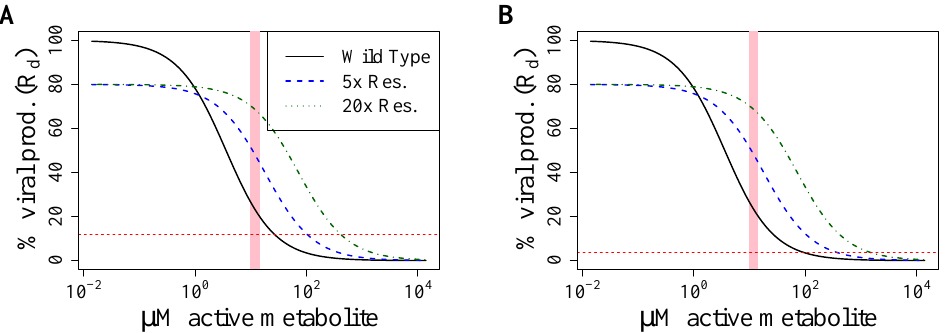
Figure 5. Resistance selection window for upper and lower respiratory tracts. ( A ) Resistance selection window for the upper respiratory tract ( R 0 = 8.5); ( B ) resistance selection window for the lower respiratory tract ( R 0 = 27.5). In both figures, the x -axis shows the intracellular RDV-TP concentration on the x -axis and the relative viral production rate (and therefore R d ) on the y -axis (as obtained with Equation (3)). The solid black line shows the wild-type, the dotted lines the arbitrary resistance mutations with a 20% fitness cost and a 5 × (blue) or 20 × (green) increased K D . The pink shaded area shows the intracellular RDV-TP ranger measured in phase I trials [15]. The red dotted line marks when R d would become 1 for the upper ( A ) and lower ( B ) respiratory